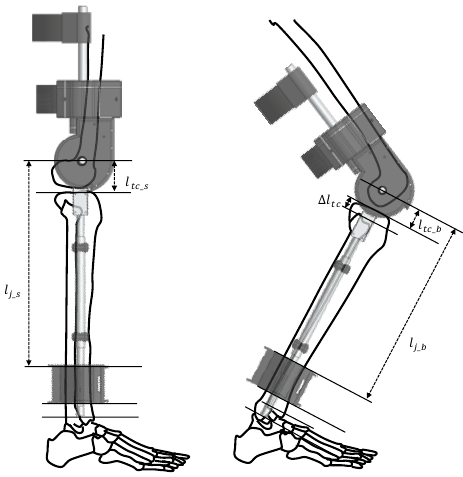
Figure 4. Movement of ankle variable section while moving the knee. As the knee flexes, the LBKA becomes shorter. As a result, the lower frame length of the exoskeleton becomes shorter.